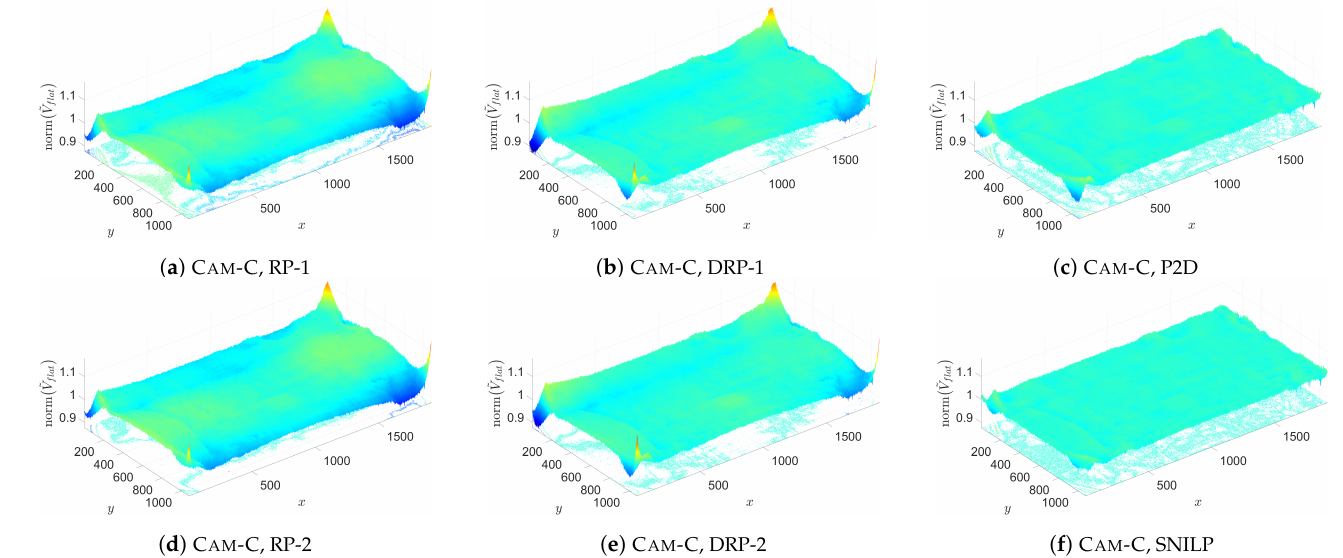
Figure A6. Comparison of vignetting corrections of flat-field image I V for C AM